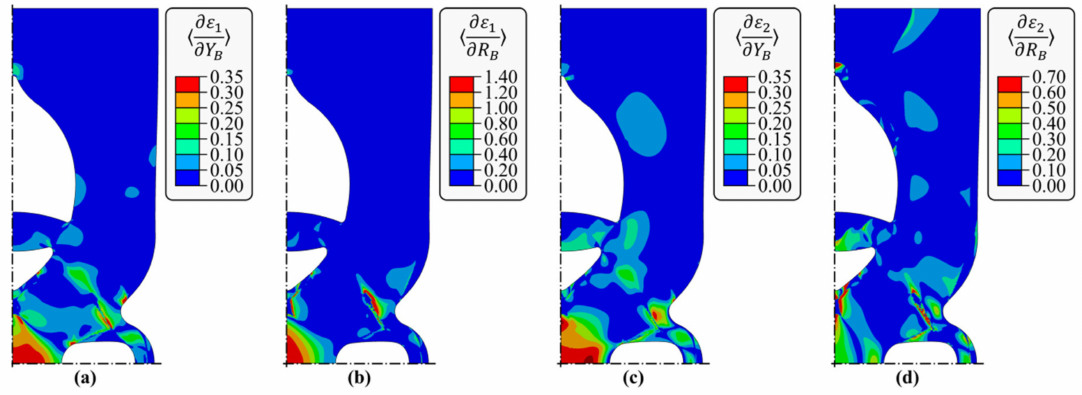
ε 1 to a change of R B , ( c ) relative